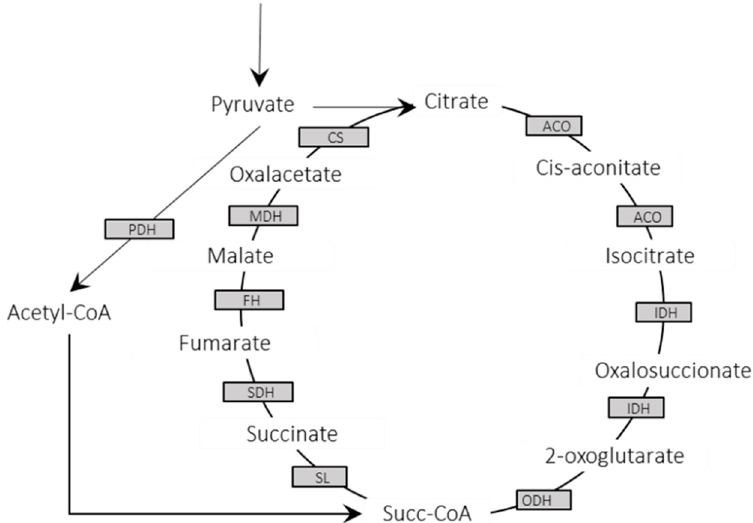
Figure 3. Detected enzymes in the L. infantum JPCM5 proteome composing the complete tricarboxylic acid (TCA) cycle. PDH: pyruvate dehydrogenase; ACO: aconitase; IDH: isocitrate dehydrogenase; ODH: 2-oxoglutarate dehydrogenase; SL: succinyl-CoA ligase; SDH: succinyl dehydrogenase; FH: fumarate hydratase; MDH: malate dehydrogenase; and CS: citrate synthase.